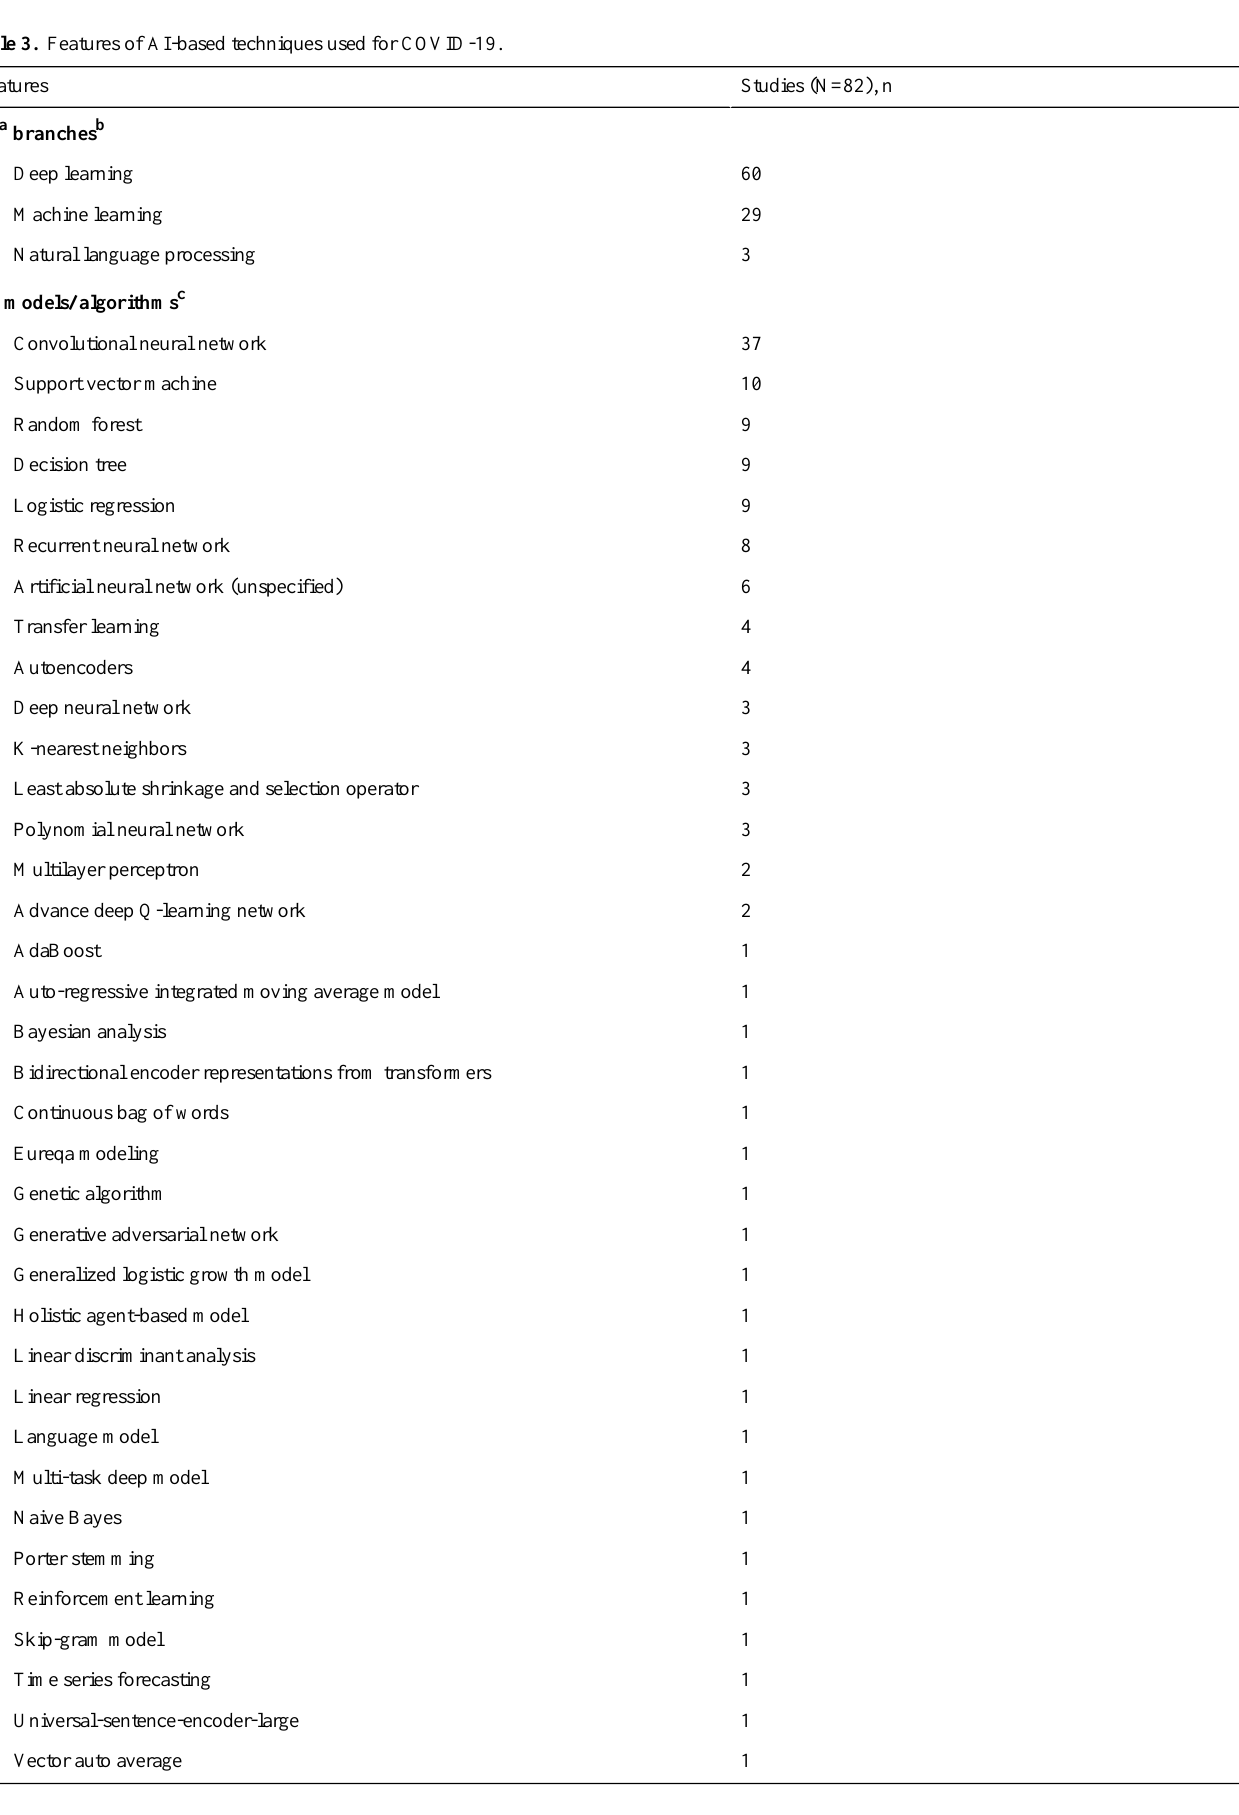
Table 3. Features of AI-based techniques used for COVID-19.